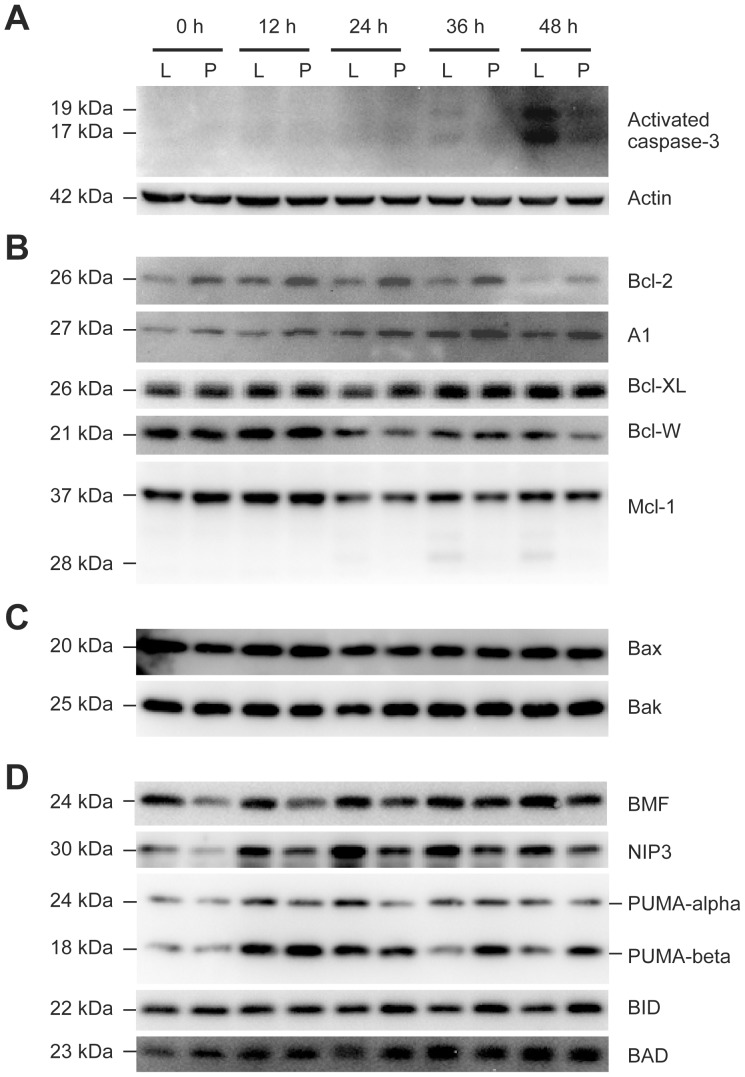
Changes of Bcl-2 family proteins in siPrP and siLuc cells after doxorubicin treatment.Immunoblot analysis of activated caspase-3 (A) and Bcl-2 family proteins (B, C, D) after incubation with 1.25 µg/mL doxorubicin for indicated time. Equal loading was verified by immunoblot analysis with an anti-actin antibody. L, siLuc cells, P, siPrP cells.